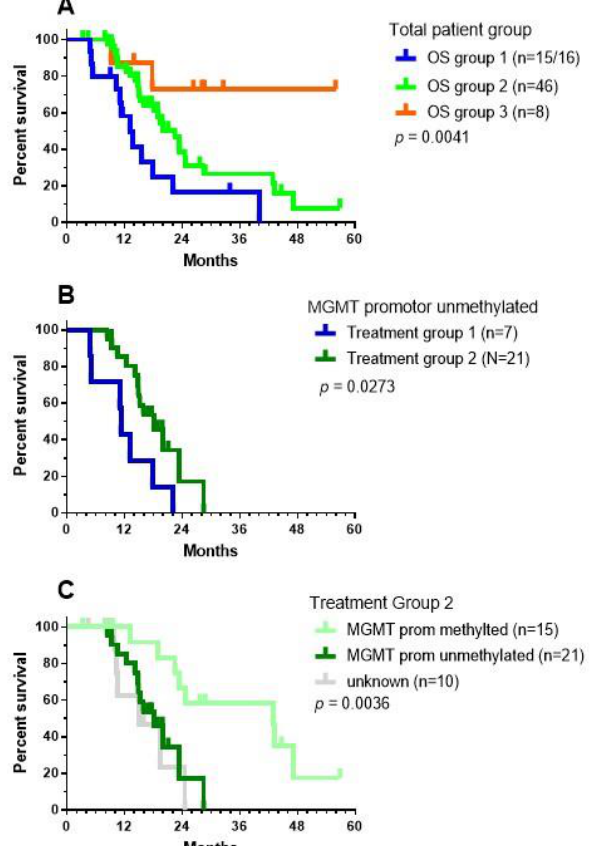
Figure 6. OS data for the treatment groups. As explained in the text, patients were categorized into three different treatment groups: ( A ) OS data for the three different patient groups; ( B ) OS data for the patients without MGMT promotor methylation belonging to treatment groups 1 (blue) and 2 (green); and ( C ) OS data of patients from treatment group 2, divided according to MGMT promotor methylation status. The p -values show the significance calculated using the Log-rank (Mantel–Cox) test.